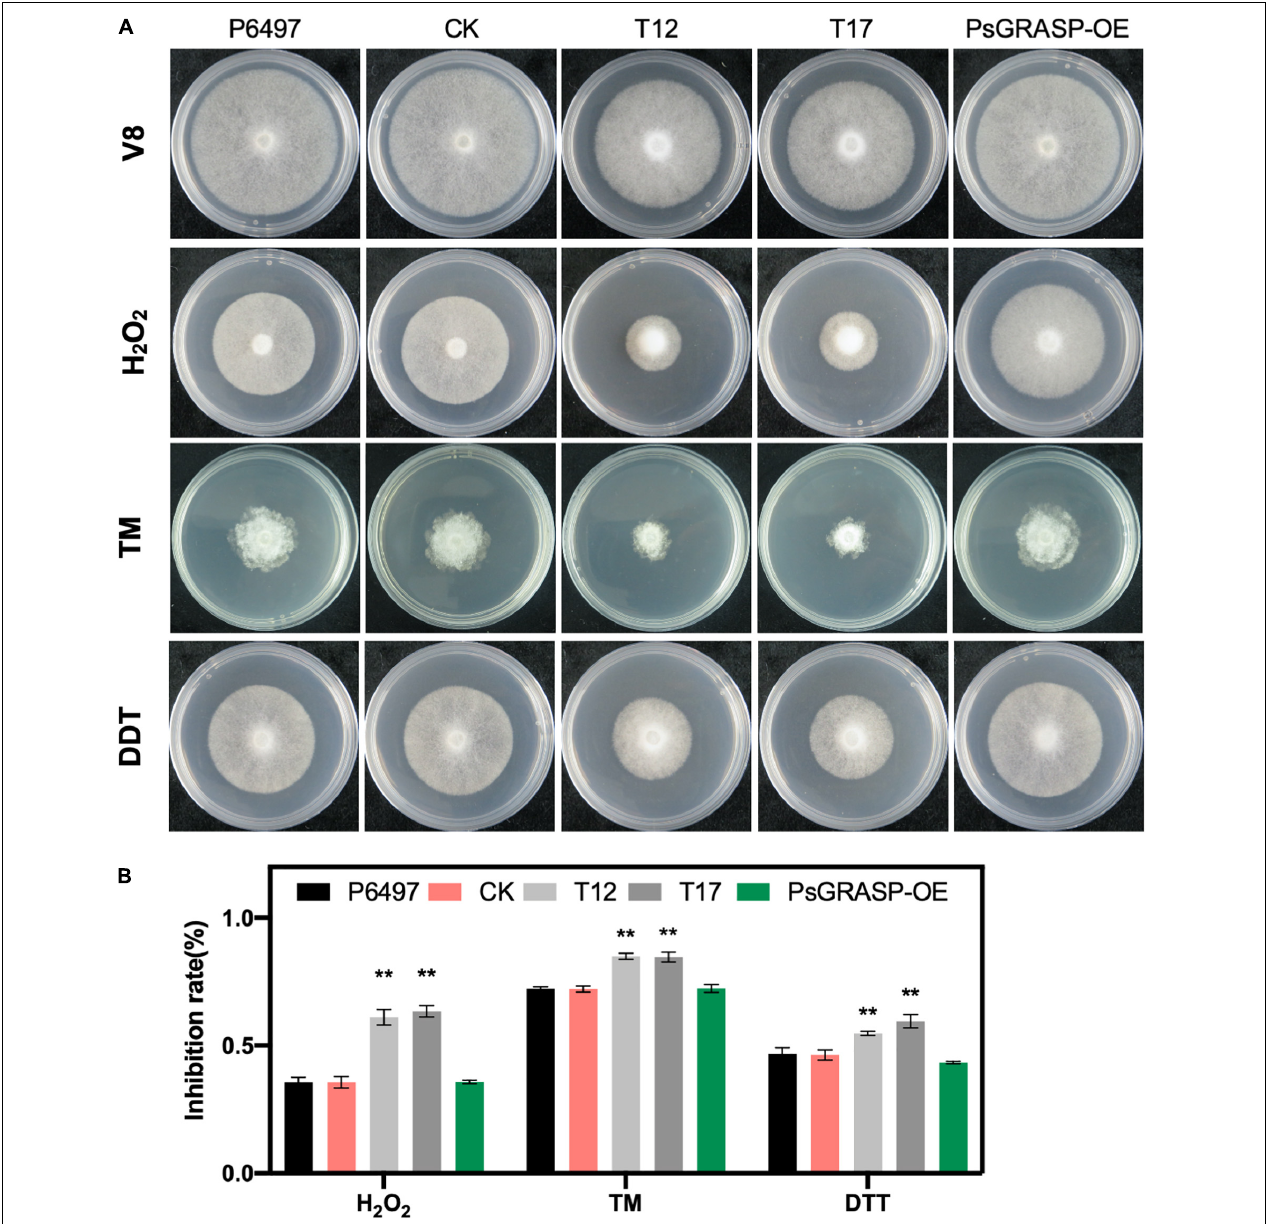
FIGURE 5 | Mycelial growth assays under different stress conditions. (A) Mycelial growth assays of P6497, CK, T12, T17, and PsGRASP-OE lines on V8 agar medium and media supplemented with H 2 O 2 , TM or DTT. TM, tunicamycin. DTT, Dithiothreitol. (B) Colony diameters were measured after five and a half days of growth. Growth inhibition Rates were calculated for each treatment relative to the growth on the V8 agar medium without supplements. Three biological replicates were performed. Error bars denote SD. ** P < 0.01, Student’s t